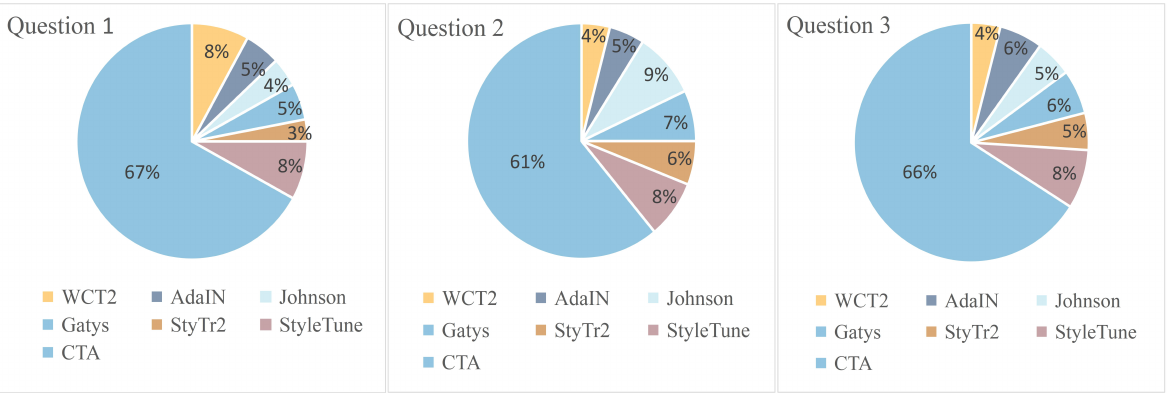
Figure 7. Questionnaire results of question 1, 2 and